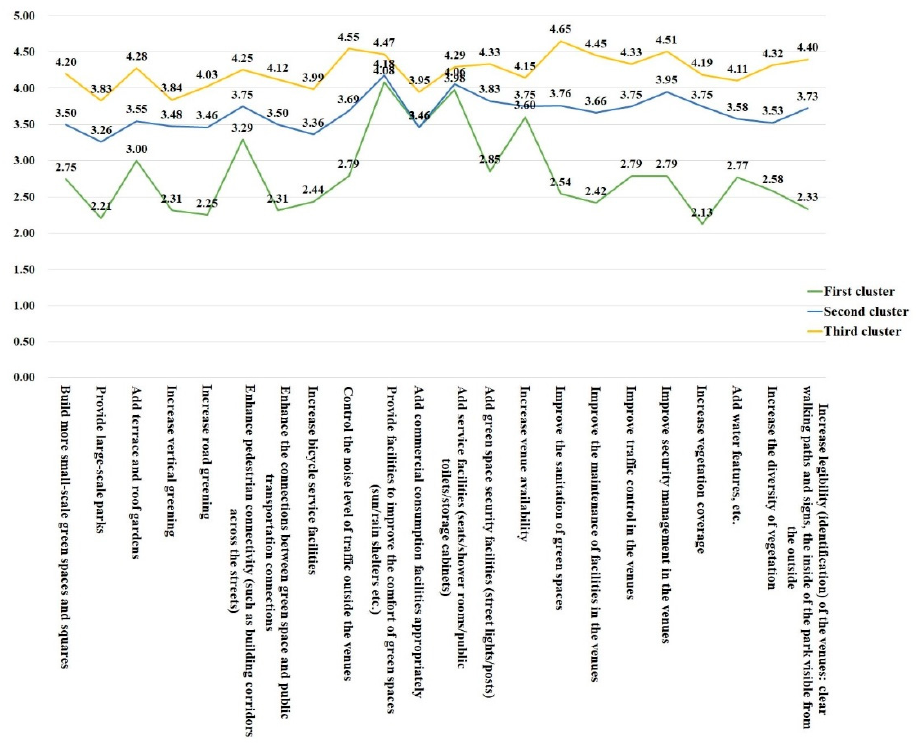
14 of 25 Table 6. Mean value of green exposure in different clusters (three clusters).